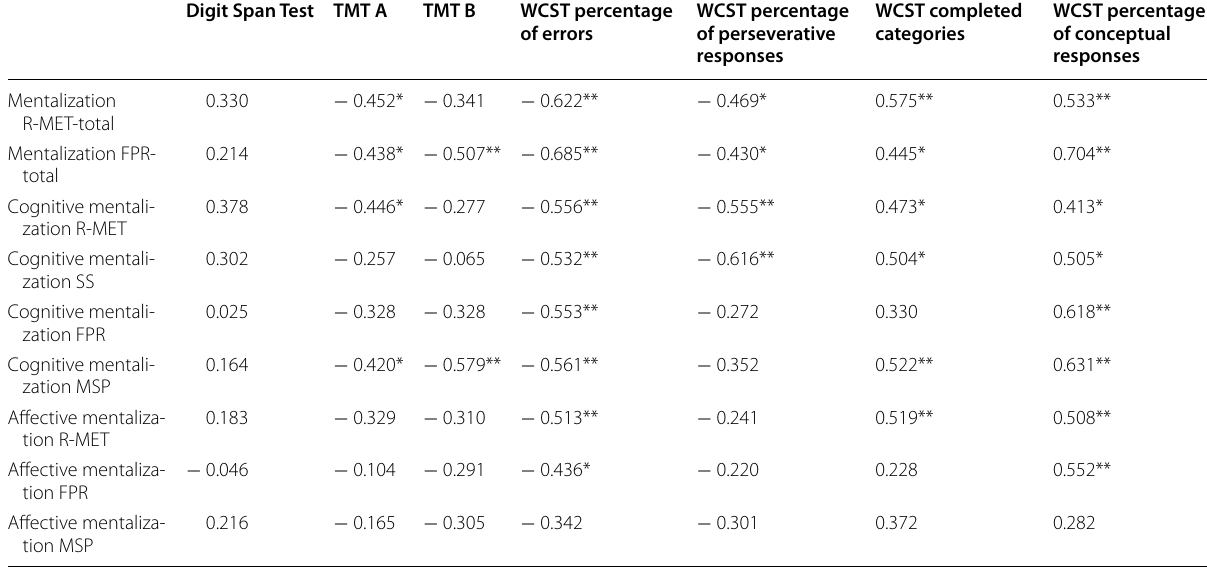
Table 3 Relationship between mentalization assessed by the Reading the Mind in the Eyes (R-MET), Strange Stories (SS), Faux Pas Recognition (FPR), and Moving Shapes Paradigm (MSP) tests and the results of cognitive function tests: a corre- lation analysis in a depressive episode